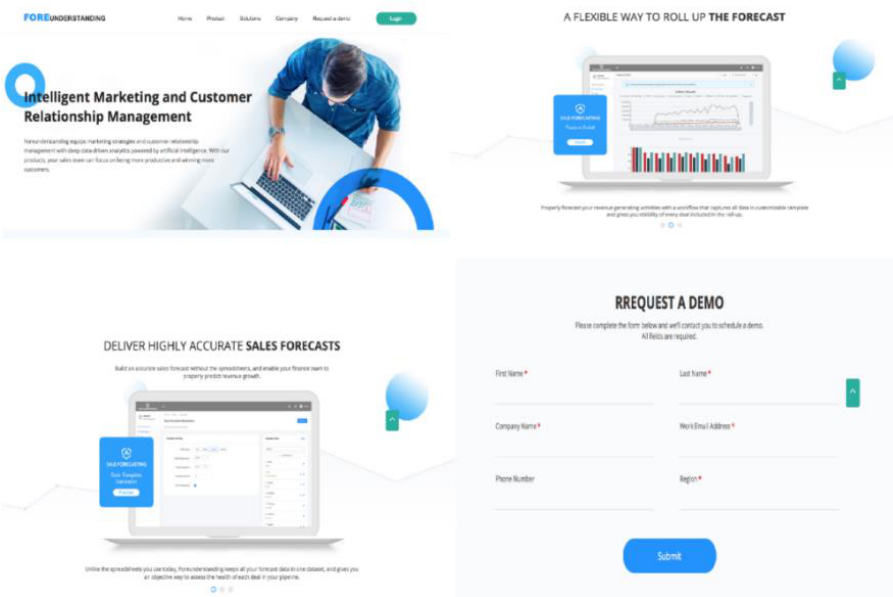
Figure A1. Home page of the sales data prediction and analysis decision system.